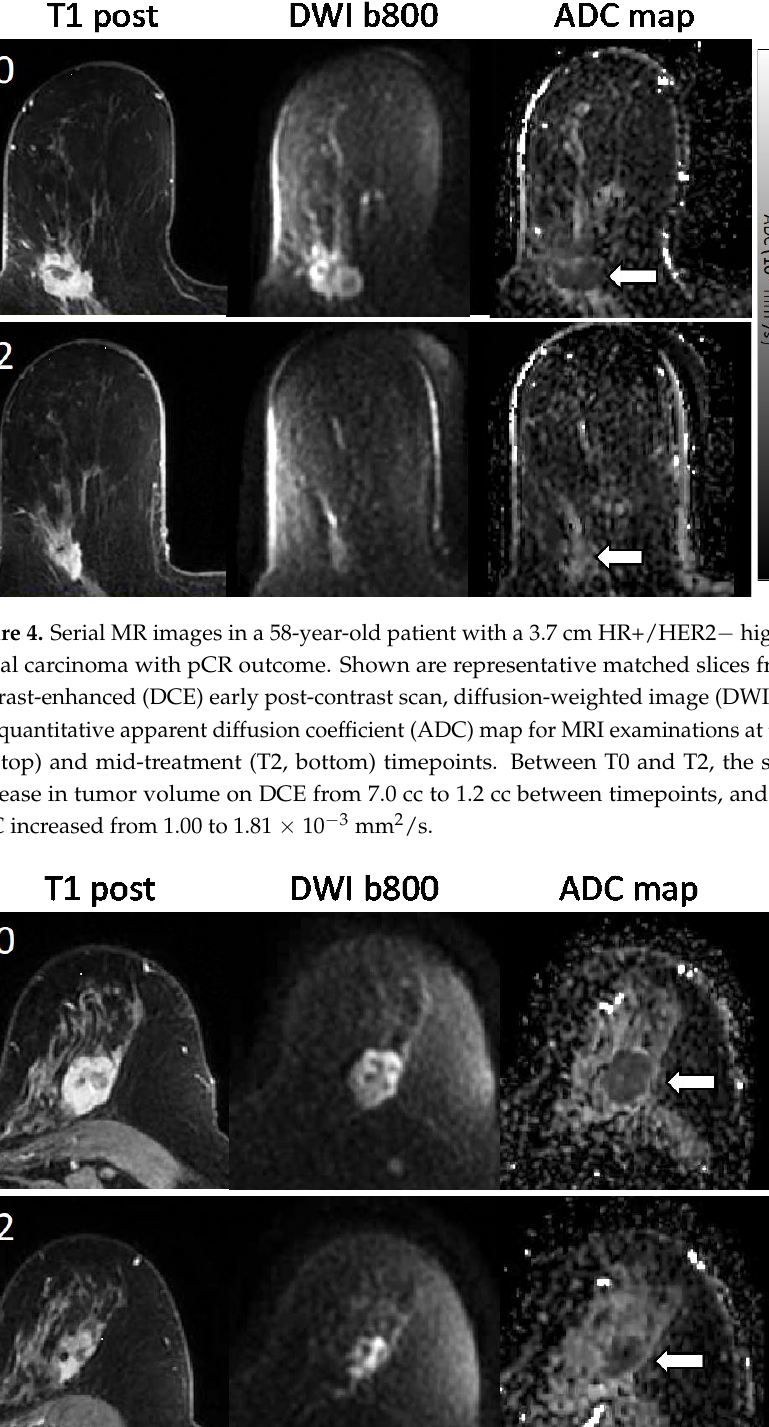
Figure 5. Serial MR images in a 57-year-old patient with a 3.2 cm HR+/HER2 − high-grade invasive ductal carcinoma with non-pCR outcome. Shown are representative matched slices from the dynamic contrast-enhanced (DCE) early post-contrast scan, diffusion-weighted image (DWI; b = 800 s/mm 2 ), and quantitative apparent diffusion coefficient (ADC) map for MRI examinations at the pre-treatment (T0, top) and mid-treatment (T2, bottom) timepoints. Between T0 and T2, the subject showed a decrease in tumor volume on DCE from 12.7 cc to 5.2 cc, while the mean tumor ADC remained unchanged at 0.92 × 10 − 3 mm 2 /s.